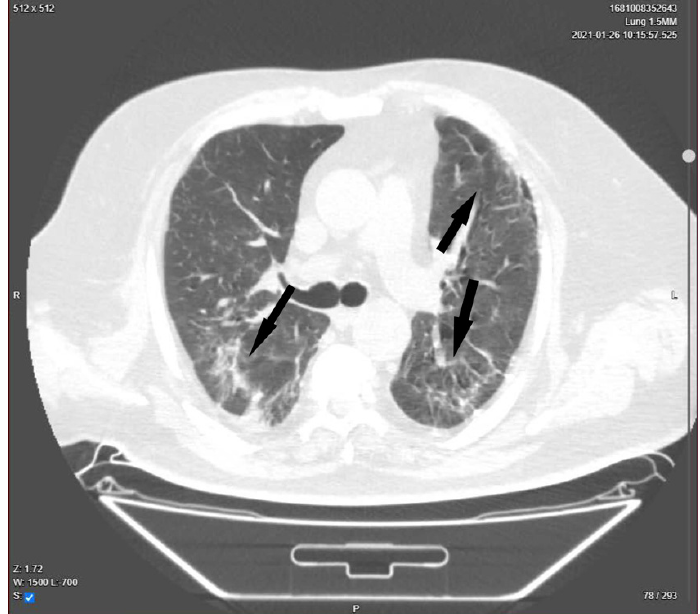
Figure 3. Chest CT. The arrows indicate areas of ground-glass opacities, summing up to 40% pulmonary damage. Day 23 of admission.